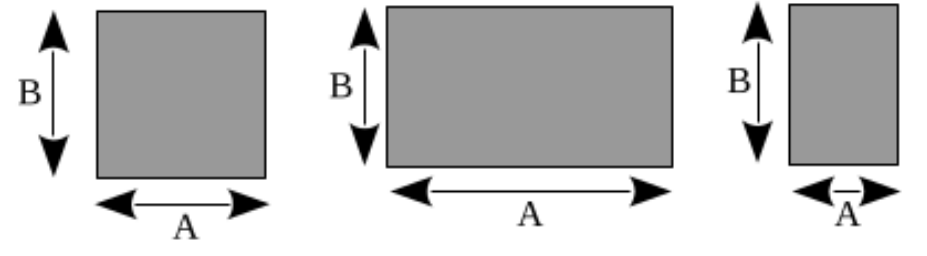
Figure 4. The layout of the rectangular piles for CFD simulations with different aspect ratios ( B : A ) of 1:1 ( left ), 1:2 ( middle ), 2:1 ( right ). B is the length of rectangular piles and A is the breadth of the piles.